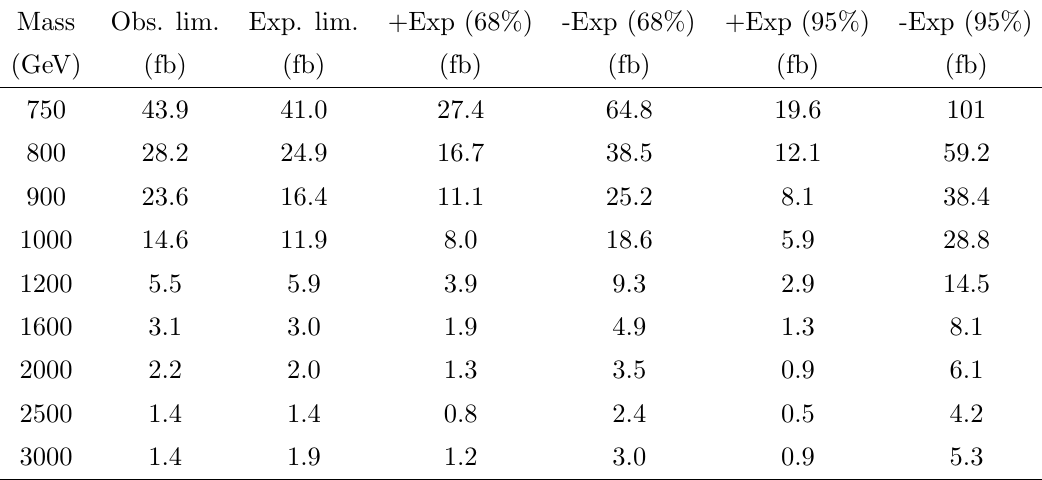
Table 4 . The observed and expected upper limits on the products of the cross sections and branching fraction (cid:27) (pp ! X) B (X ! HH ! bbbb) for a bulk graviton from the combination of the fully-merged and semi-resolved channels (where the events used in the fully-merged analysis are not considered in the semi-resolved analysis). Results above 2000 GeV are taken directly from the fully-merged analysis [39].